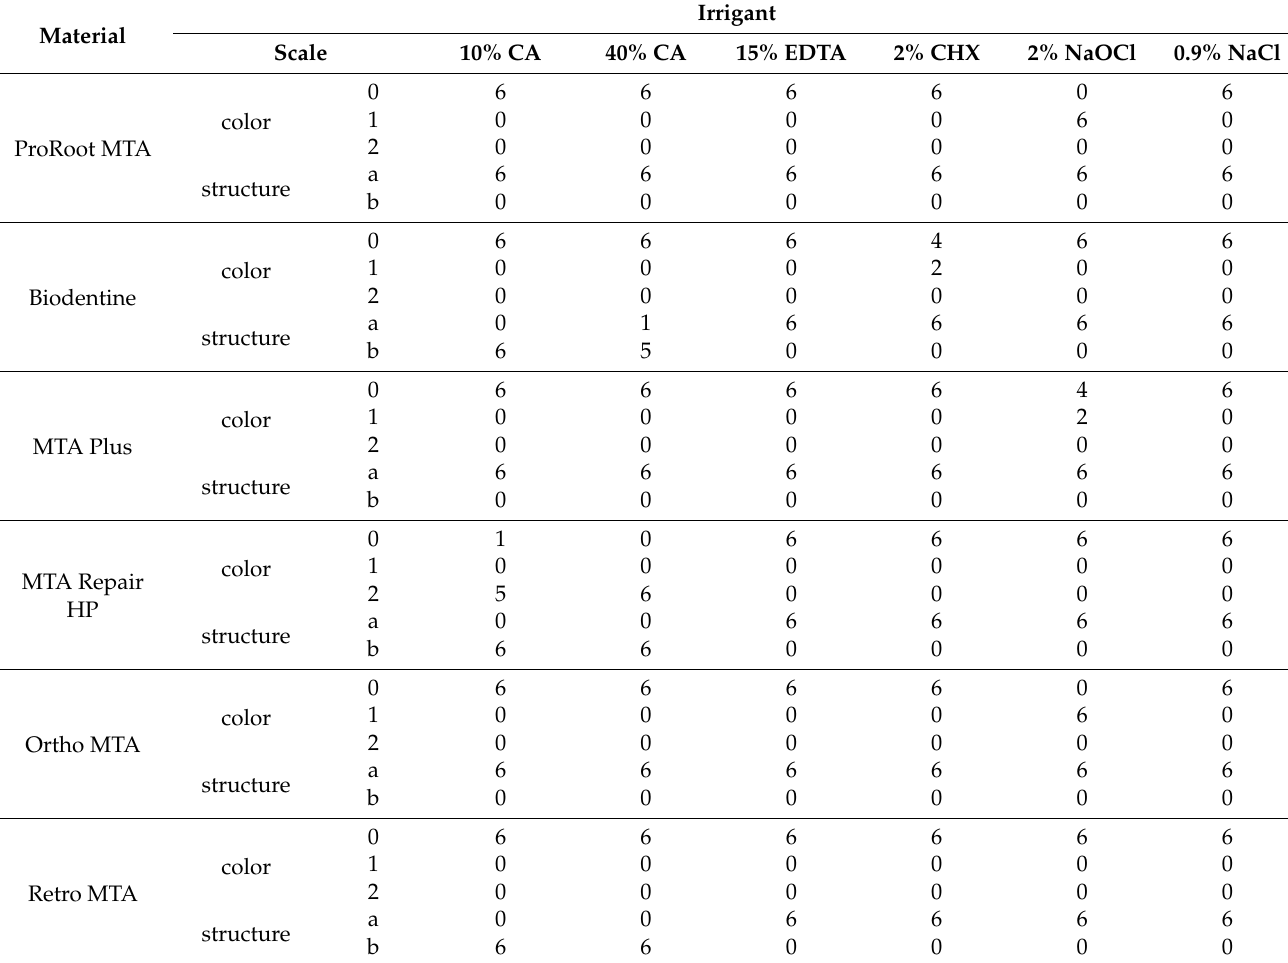
Table 2. Evaluation of the changes in the color and structure of CSC materials upon contact with different irrigation solutions.